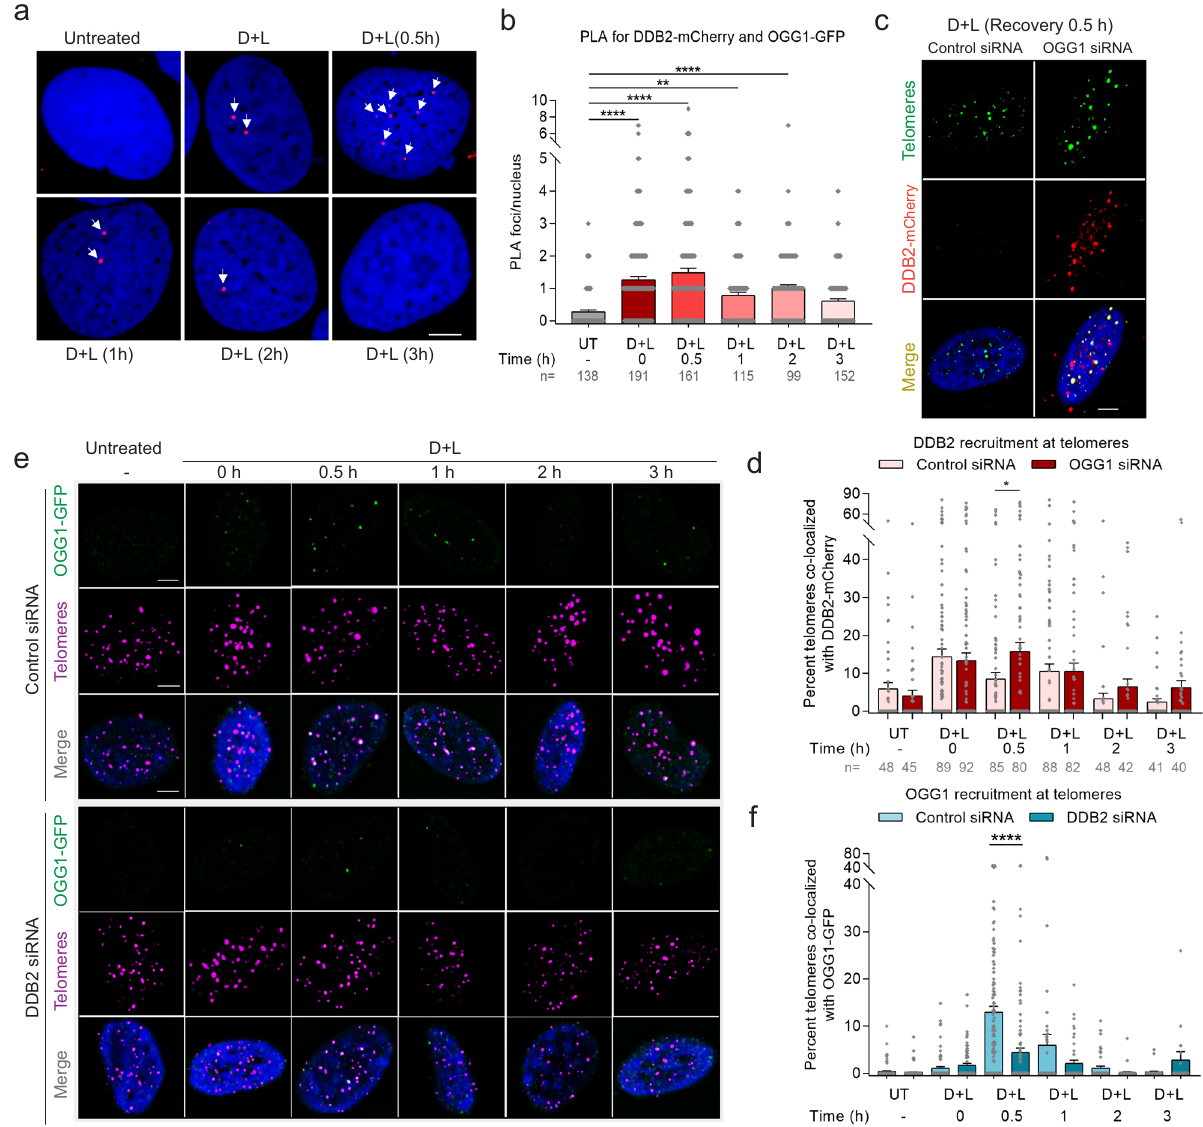
Fig. 2 DDB2 is required for ef fi cient OGG1 recruitment to 8-oxoG. a DDB2-mCherry and OGG1-GFP associate at 8-oxoG sites as shown by PLA after dye (100 nM, 15 min) plus light (660 nm, 10 min) treatment, over a period of 3 h. Antibodies against mCherry and GFP were used. b Quanti fi cation of PLA. c Accumulation of DDB2-mCherry at telomeric 8-oxoG 30 min post dye plus light treatment in U2OS-FAP-TRF1 cells transfected with control or OGG1 siRNA. d Percent telomeres colocalized with DDB2-mCherry as shown in (c). e Recruitment of OGG1-GFP at damaged telomeres in cells transfected with control or DDB2 siRNA. f Percent telomeres colocalized with OGG1-GFP as shown in ( e ). Data ( a – f ) represents mean ± SEM from two independent experiments. “ n ” represents the number of cells scored for each condition. One-way ANOVA (Sidak multiple comparison test): * p < 0.05, ** p < 0.01, **** p < 0.0001. Scale: 5 µ m. Source data are provided as a Source Data fi le. (See also Supplementary Fig.